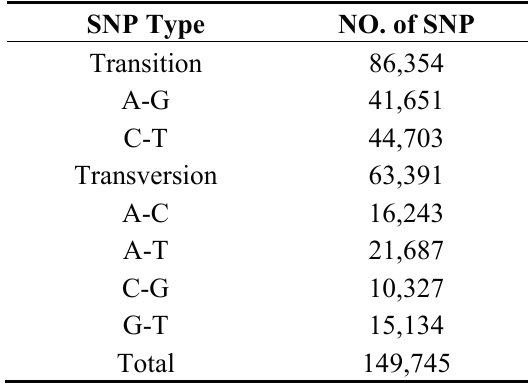
Table 3. Summary of SNP identified from the sea cucumber coelomocytes